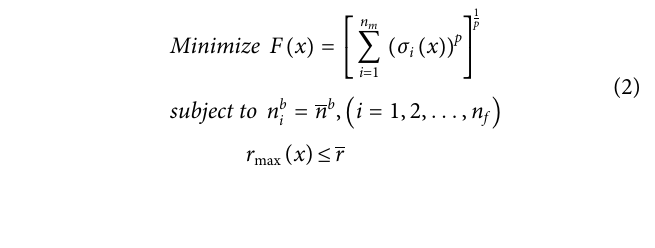
Frontiers in Built Environment |